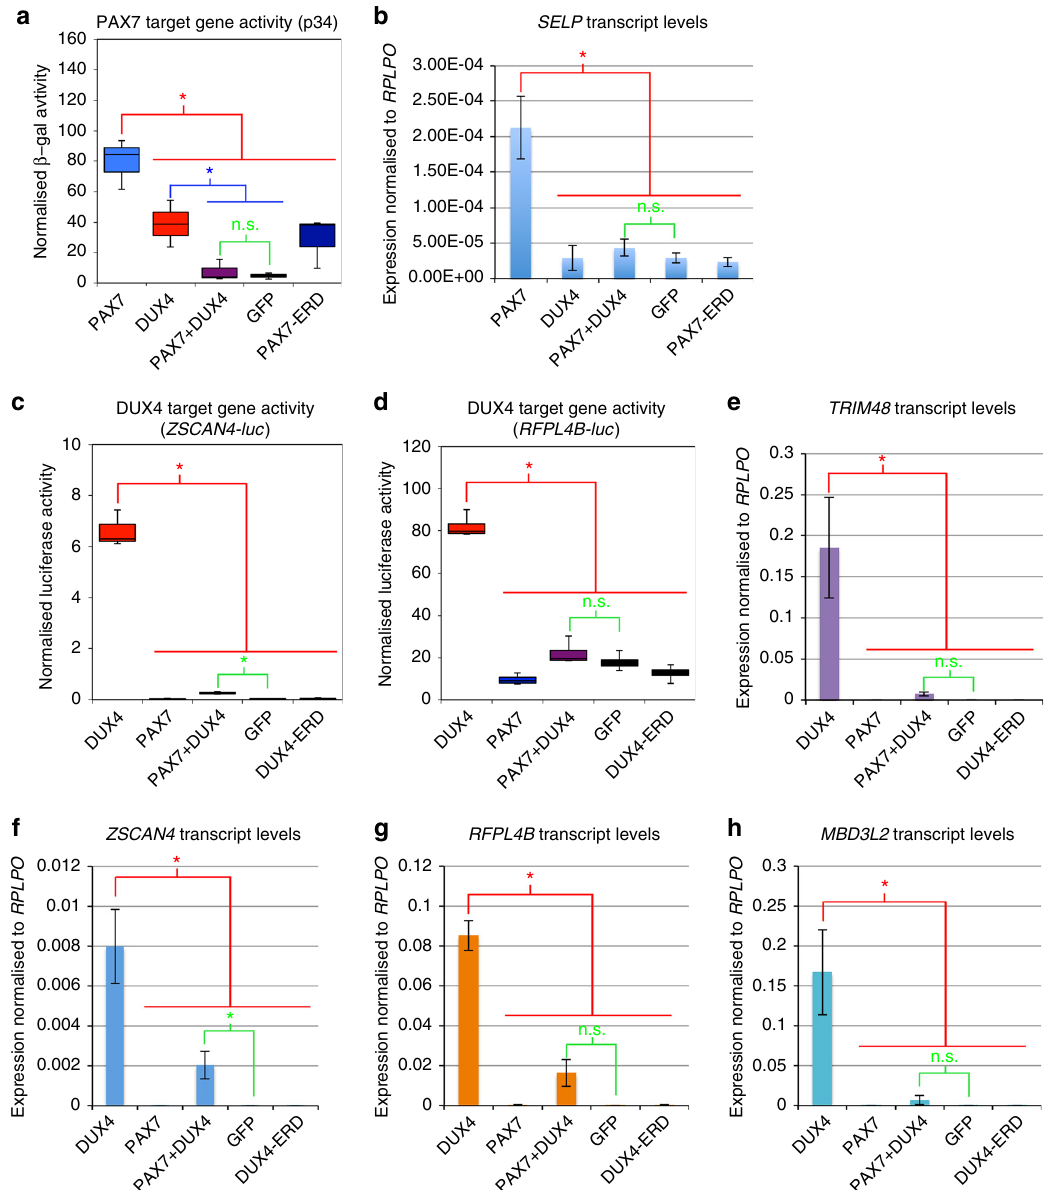
Fig. 6 Co-expression of PAX7 and DUX4 causes suppression of the transcriptional activity of both proteins. HEK-293 or NIH-3T3 cells were transfected with plasmids encoding DUX4 , Pax7 , DUX4 and Pax7 , or dominant negative-version DUX4-ERD, or Pax7 -ERD. a The ability of PAX7 to activate its transcriptional target genes was measured via the p34 plasmid driving lacZ , co-transfected with the constructs listed above, together with a control RSV luciferase plasmid as a transfection normaliser, into NIH-3T3 cells. Reporter gene intensities were measured using a Glomax-Multi + plate reader and normalised to RSV luciferase. PAX7 activated the p34 PAX7 reporter construct, but both PAX7 and DUX4 together suppressed activity of this PAX7 reporter compared to PAX7 alone. b RT-qPCR for PAX7 transcriptional target gene SELP con fi rms that co-expression of Pax7 and DUX4 suppresses the activation of this endogenous PAX7 transcriptional target compared to PAX7 alone, in HEK-293. The ability of DUX4 to activate its transcriptional target genes was measured via two separate DUX4 reporter constructs: c ZSCAN4-luc and d RFPL4B-luc , both controlling a luciferase reporter gene, co- transfected with DUX4 and/or Pax7 constructs, or DUX4-ERD or GFP, together with a RSV lacZ as a transfection normaliser, into HEK-293. Reporter gene intensities were measured using a Glomax-Multi + plate reader and normalised to β -galactosidase activity. While DUX4 activated both DUX4 reporters, both PAX7 and DUX4 together, suppressed activity of these DUX4 reporters compared to DUX4 alone. RT-qPCR for DUX4 endogenous transcriptional target genes. e TRIM48 , f ZSCAN4 , g RFPL4B and h MBD3L2 con fi rms that the presence of both PAX7 and DUX4 together suppresses activation of all these endogenous DUX4 transcriptional target genes compared to the levels achieved by DUX4 alone in HEK-293 cells. Boxes represents the interquartile range (IQR), with the median indicated by a line. Whiskers denote min (1.5*IQR, max (observed value)). For bar graphs, error bars denote standard error of the mean, n = 3 or 4 for each cell line, ANOVA revealed signi fi cant intensity differences, post hoc unpaired two tailed t -tests were employed to assess signi fi cant pairwise differences: *denotes p < 0.05, and n.s. denotes non-signi fi cance of pairwise t